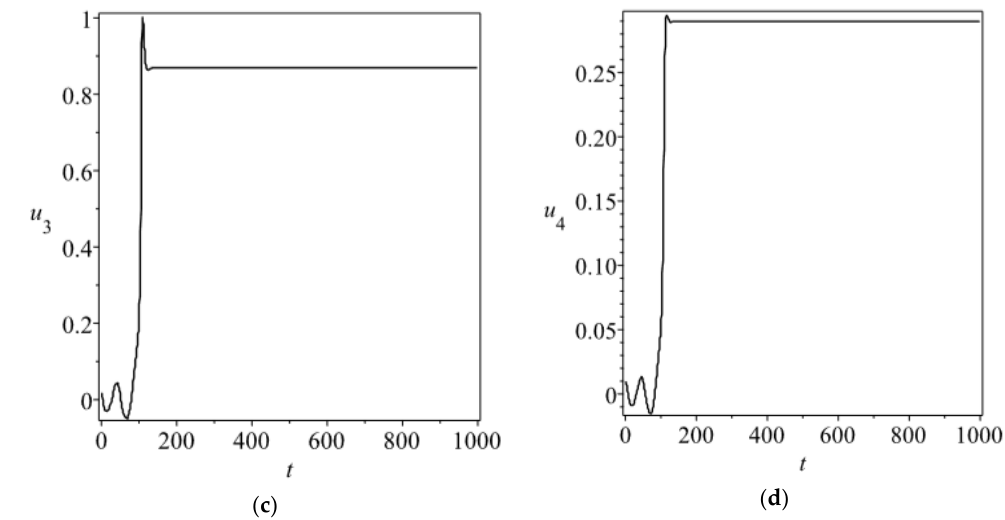
Figure 3. Dynamics of Equation (2) with a = 0.1, b = 0.08, γ = 3, c = 0.18. The initial conditions are Figure 2. Dynamics of Equation (2) with taken as u 1 ( 0 ) = 0.01, u 2 ( 0 ) = 0, u 3 ( 0 ) = 0.02, u 4 ( 0 ) = 0.01. ( a ) u 1 ( t ) vs. t ; ( b ) u 2 ( t ) vs. t ; ( c ) u 3 ( t ) vs. t ; ( d ) u 4 ( t ) vs. t